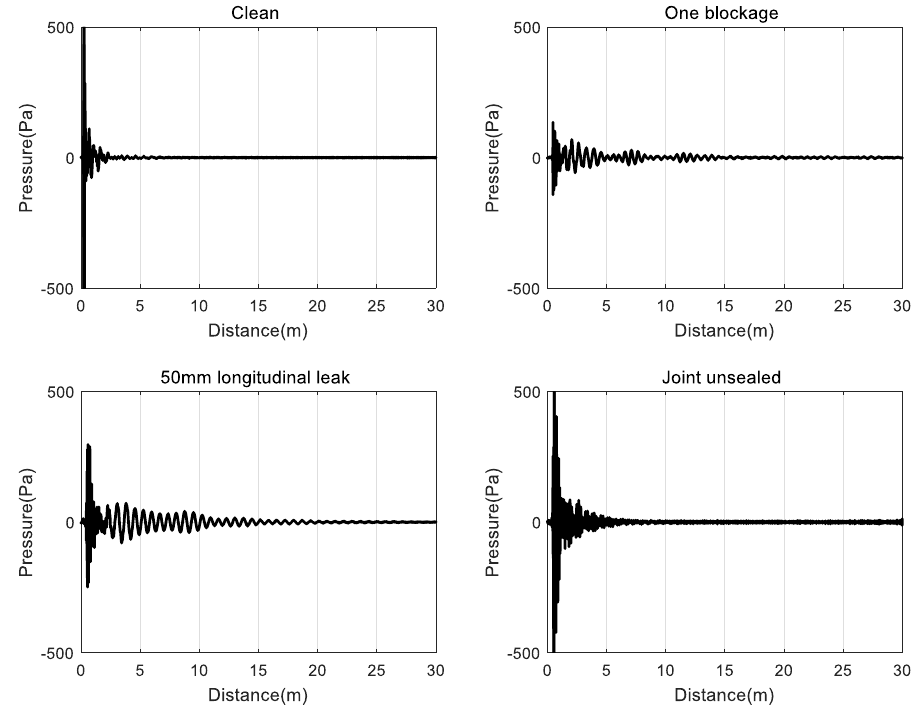
Figure 5. The acoustic pressure impulse response of four conditions in the siphon.